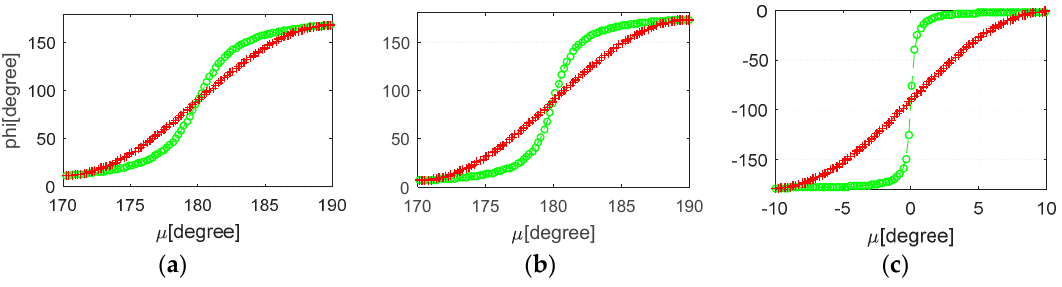
Figure 7. The yaw angle of E01 (FOC) during noon maneuver for different sun angles: ( a ) beta = − 1.99°; ( b ) beta = − 1.19°; and ( c ) beta = 0.02°. The nominal yaw angle is shown in green, while the modeled one is in red.